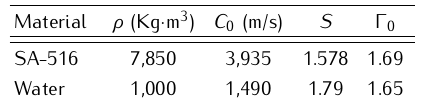
Table 7. Constants of Mie-Gruneisen equation for the steel and water.